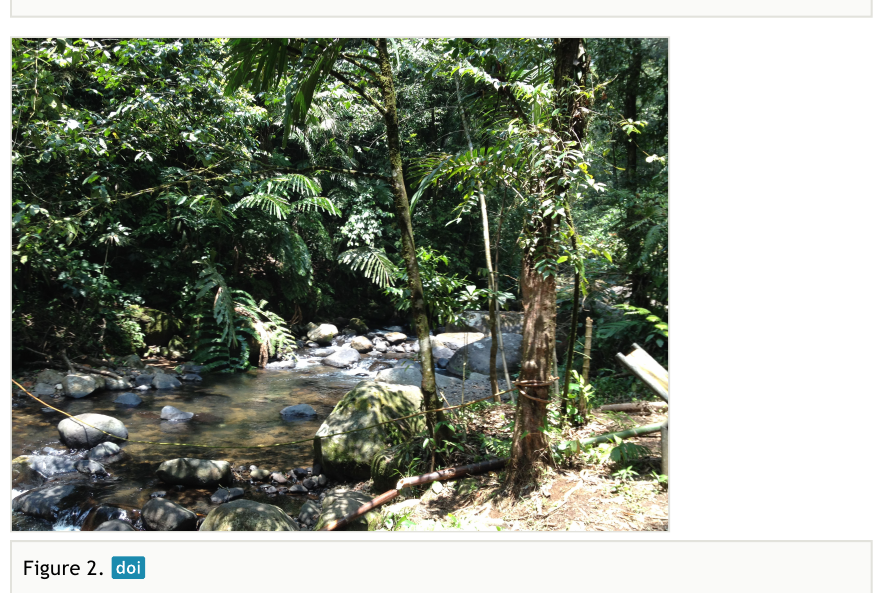
Halimun National Park (Indonesia, West Java), one of the collecting